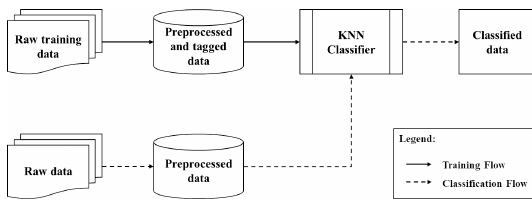
Figure 2. Classification